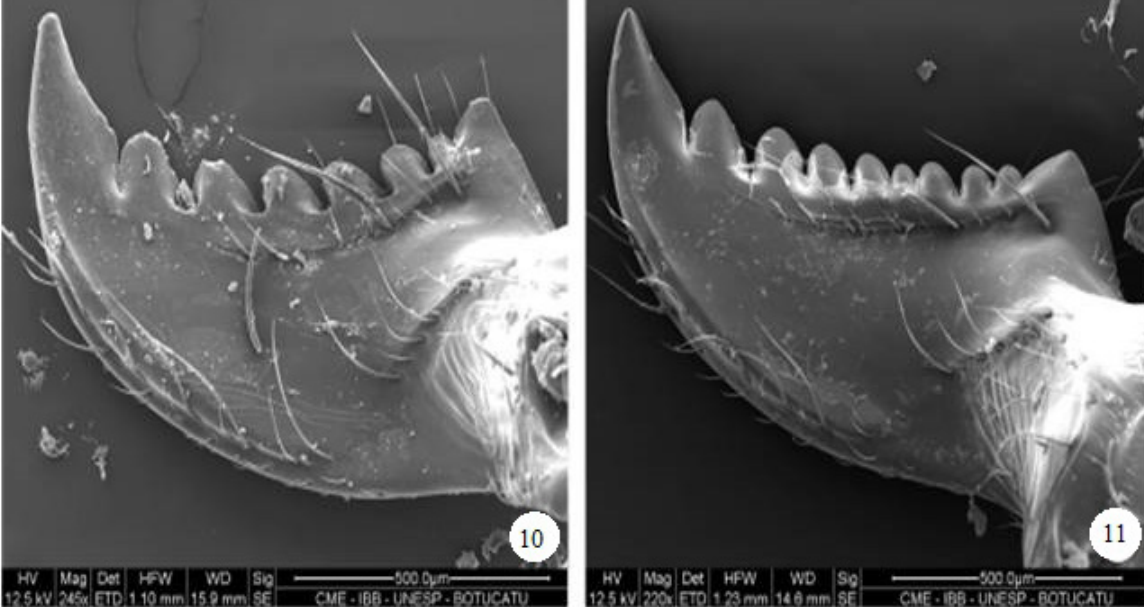
Figs 10-11 . ventral side of right mandibles of Atta sexdens rubropilosa foragers at different ages, showing natural wear due to foraging activity. Adult of undetermined age (10) and adult one day after hatching (11).